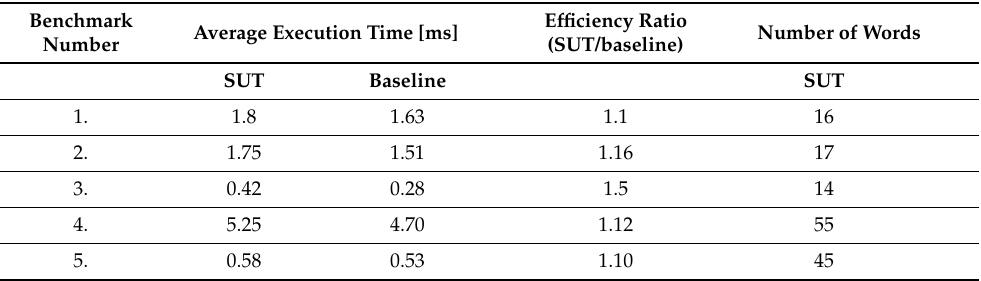
Table 5. Average Execution Time over 2000 repetitions for a set of benchmark SUTs along with their respective baseline test